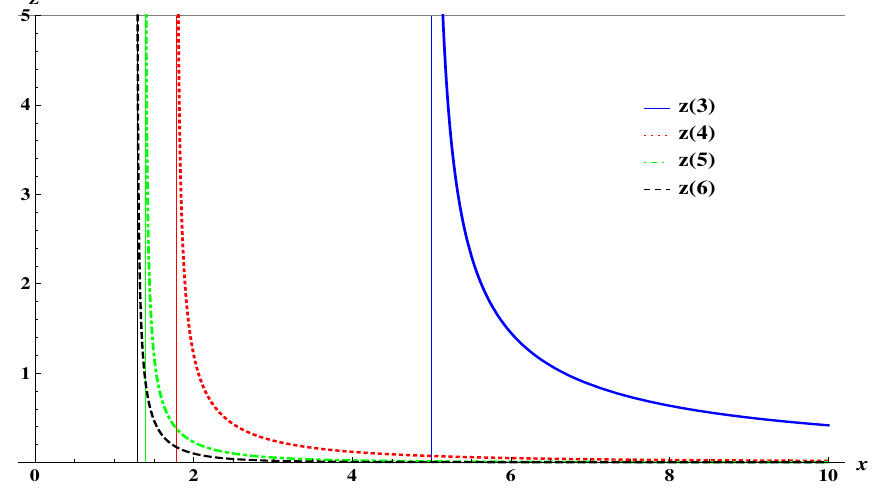
Figure 2. Redshift for different values of d in terms of x for α = 1.5 and η = 2.5. The vertical line shows the location of event horizon in each dimension and x = r 1 / (cid:96) p